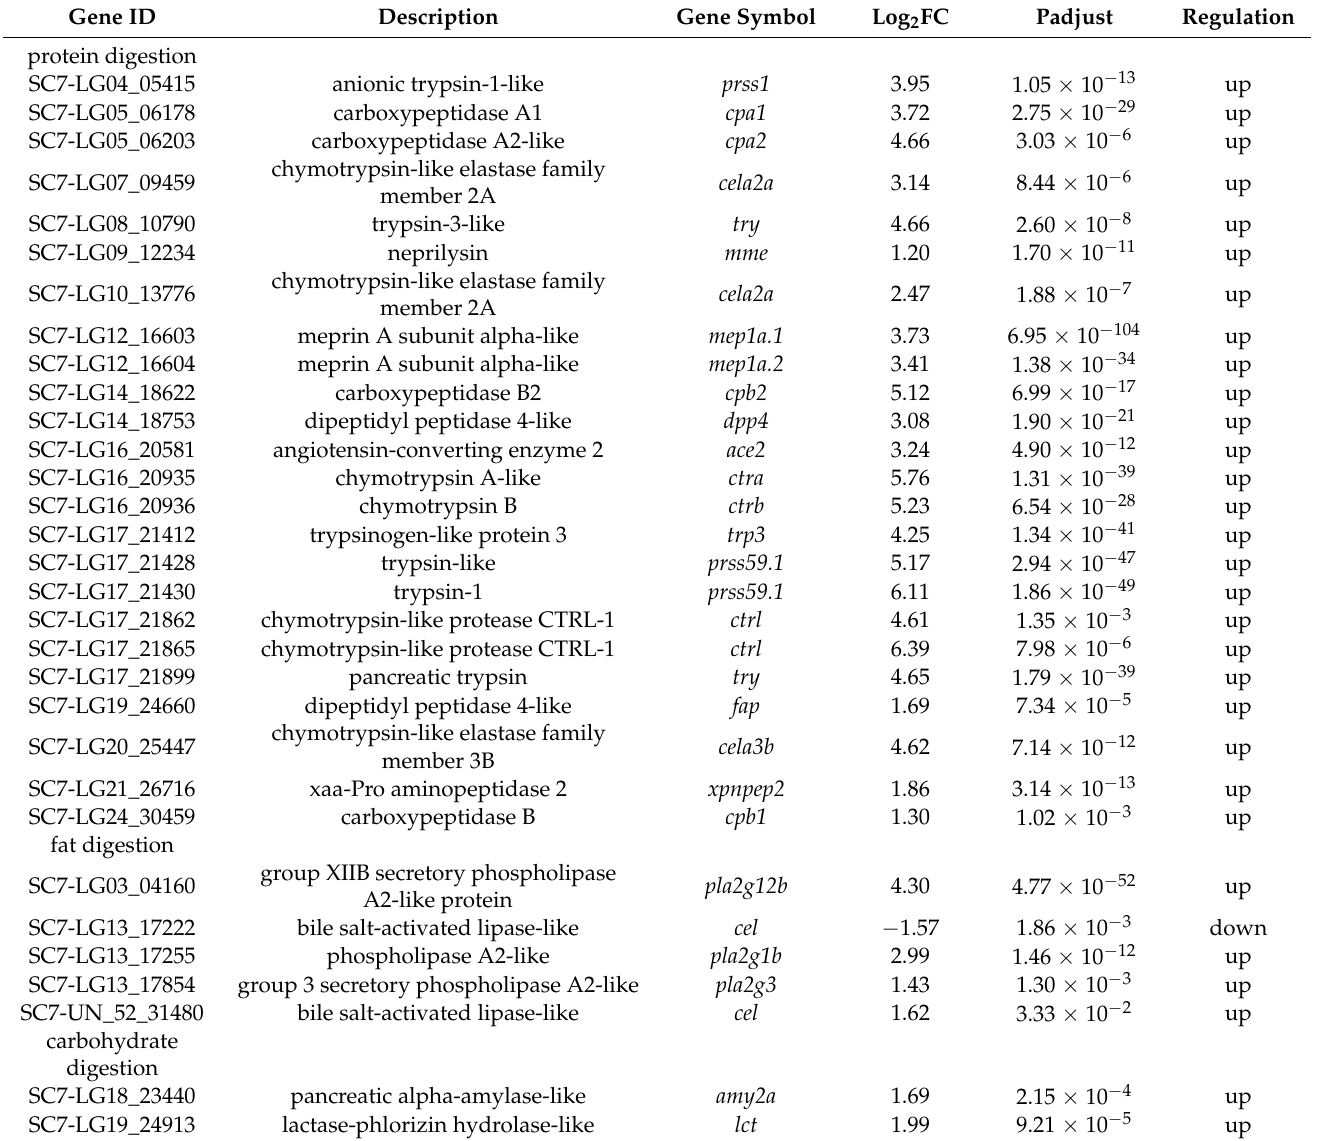
Table 3. Representative DEGs between the mandarin fish larvae unfed and fed with live prey fish.